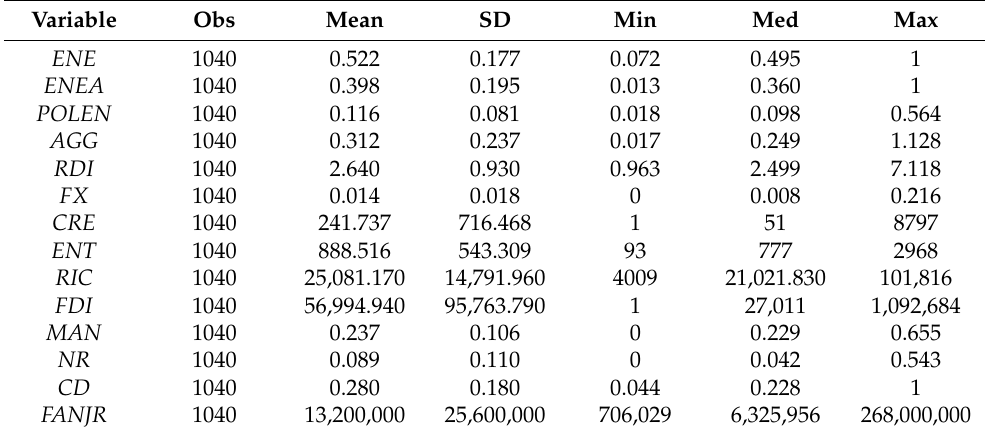
Table 2. Descriptive